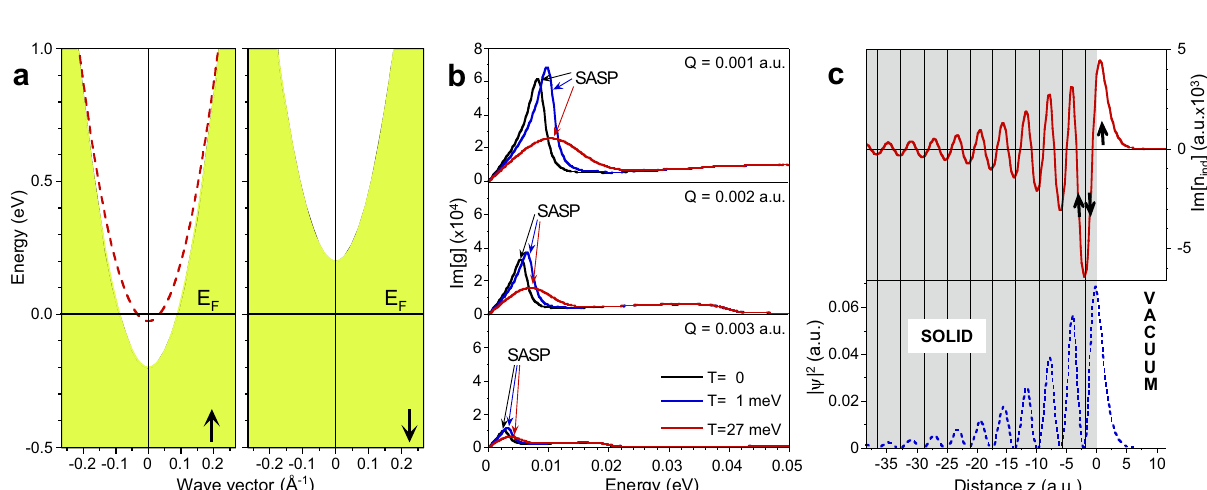
Figure 5. ( a ) Surface valence band structure of Ni(111) reproduced by a model potential. The majority-spin Shockley surface state dispersion is shown by red dashed line. The shaded regions show the projected bulk electronic state continua. Left (right) panel shows the majority- (minority-) spin part. ( b ) Surface loss function, Im 0.001 , 0.002, and 0.003 a.u. Black, blue, and red curves show it for three values of g ( Q , ω) , calculated at Q [ ] = electron temperature, 0, 1, and 27 meV, respectively. Peaks corresponding to the spin acoustic surface plasmon are marked as SASP. ( c ) Imaginary part of charge density corresponding to the acoustic surface plasmon 0.001 a.u. and ω 2.6meV (red solid line). Blue dashed line shows charge density of the majority- at Q = = spin Shockley surface state. Vertical solid lines indicate the atomic layer positions. Origin of the horizontal coordinate locates at a nominal crystal